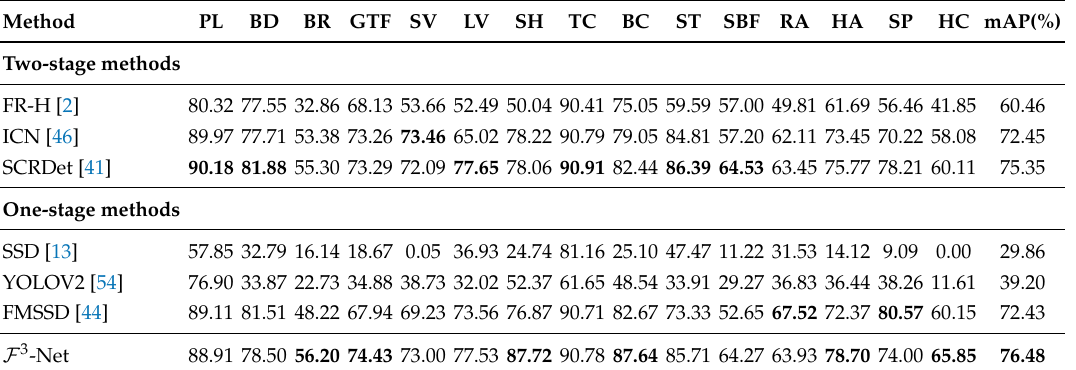
Table 3. Experimental comparison of the baselines and our F 3 − Net for HBB task on DOTA test set.